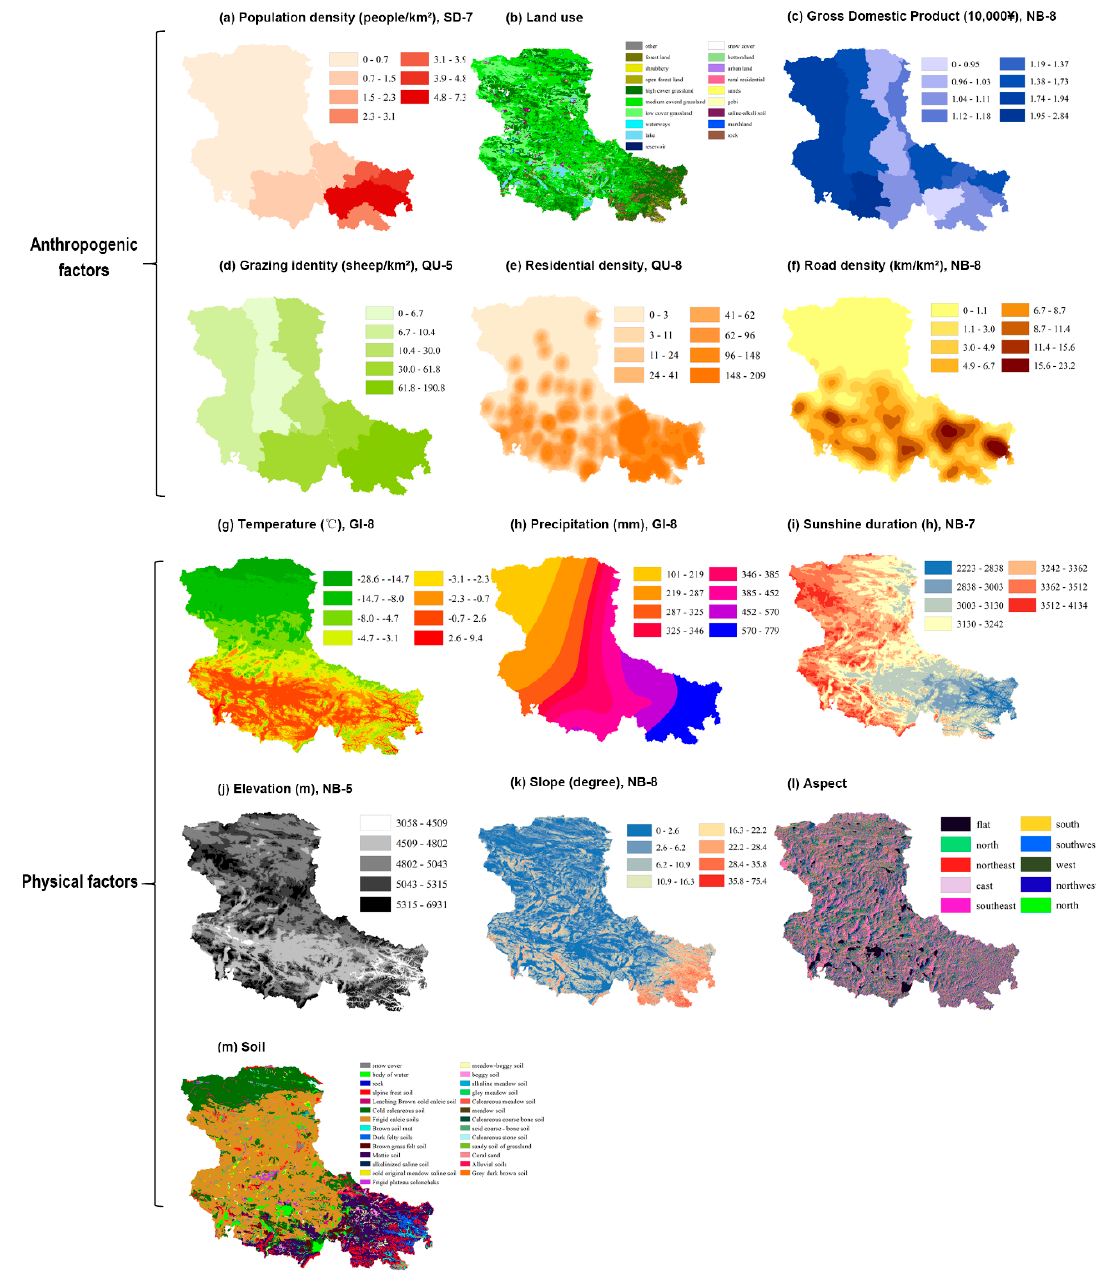
Figure 2. The spatial distribution of physical factors (temperature, precipitation, sunshine duration, elevation, aspect, slope, and soil type) and anthropogenic factors (population density, land use, per capita GDP, grazing density, residential density, and road density) in northern Tibet. Gradient colors are used to reflect the discretization results of continuous variables, such as temperature, precipitation, sunshine duration, elevation, slope, population density, per capita GDP, grazing density, residential density, and road density. The categorization method of each variable was attached to the sub-graph title. EI, NB, QU, GI and SD stand for the discretization methods of Equal Interval, Natural Break, Quantile, Geometrical Interval and Standard Deviation, respectively. The number 2–8 means the discrete intervals of each method.